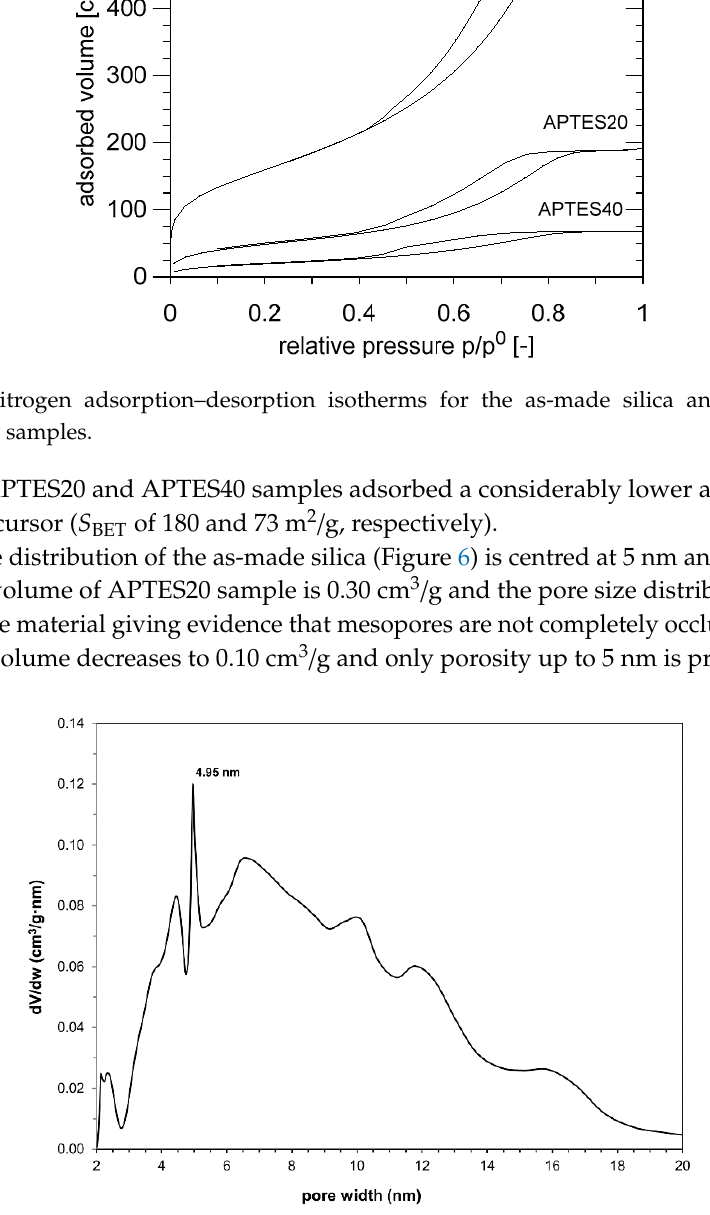
Figure 6. BJH pore size distribution for the as-made silica studied.